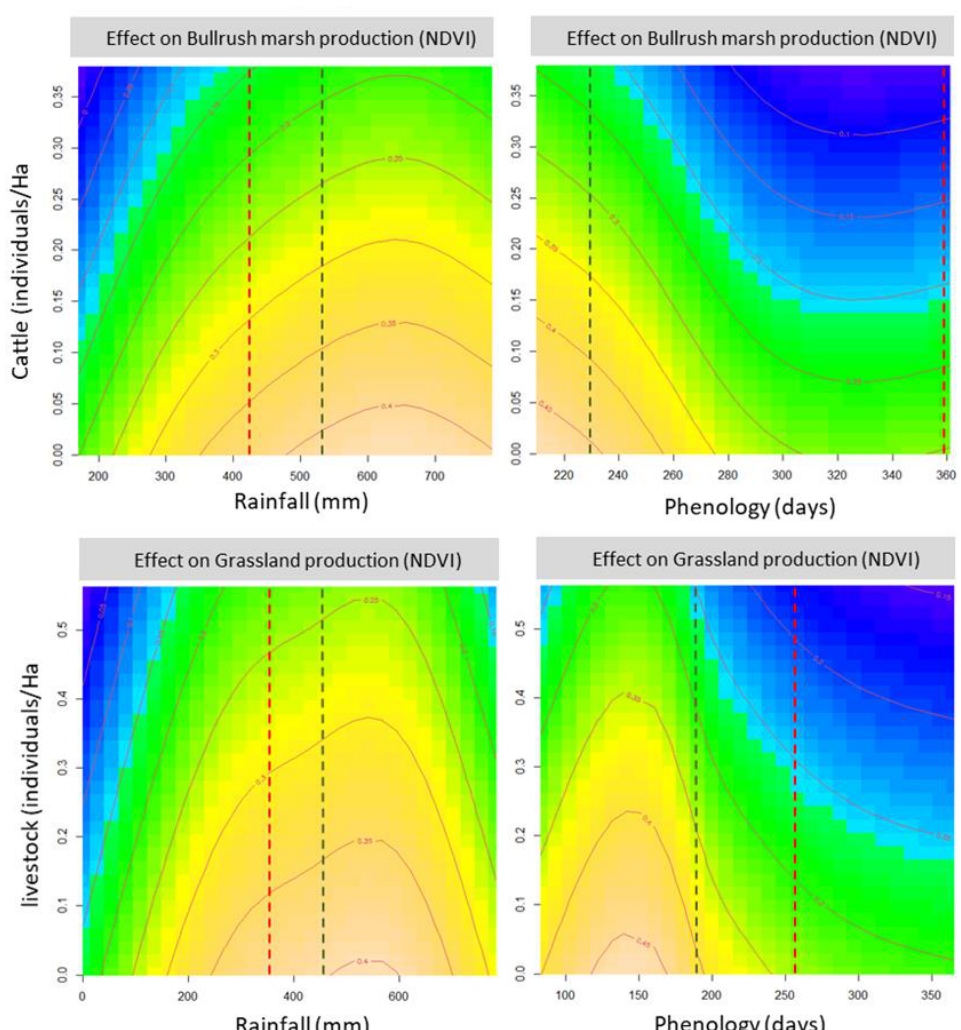
Figure 5. Model prediction plots describing the combined effect of climatology (either rainfall, left panels, or phenology, right panels) and grazing pressure exerted by domestic ungulate species, including only those with significant effects on each vegetation type. Note that the color palette varies among graphs, i.e., the same color does not indicate the same range of production values (as indicated at the contour plots) in all graphs. Vertical dashed lines indicate the observed (green color; 1961–2000) and predicted (red color; 2041–2070, using the MIROC RCP4.5 scenario) values of accumulated rainfall and phenological peak (calculated, respectively, for the mean day of occurrence of the phenological peak or the corresponding value of accumulated rainfall in our 2000–2014 data series), obtained from REDIAM’s ADVECRA (available at: https://kerdoc.cica.es/cc?lr=lang_es accessed on 20 October 2020). For simplicity, we pooled the (significant) effects of cattle and horse in a single factor named ‘livestock’, using a HGAM model with these variables pooled (which showed a 99% correlation with the predictions of the model with separate variables discussed above: see Figure A4, Appendix